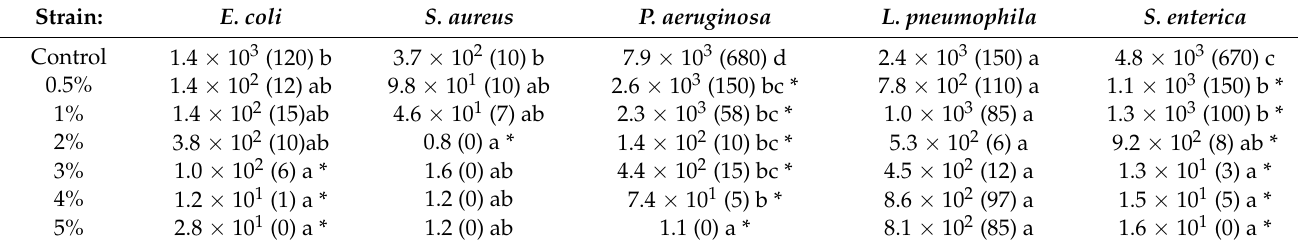
Table 1. Number of viable bacterial cells after incubation CFU/cm 2 (mean ± standard deviation in brackets). Statistically significant differences in the columns are marked with different letters. Control: sample without biocide; 0.5–5%: samples with appropriate biocide content; *: statistically significant differences from control for p <